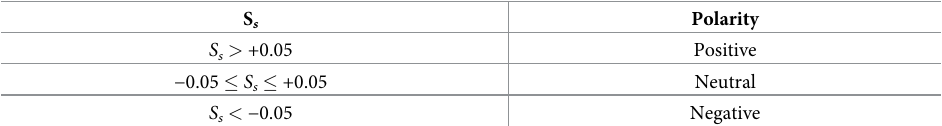
Table 1. Compound sentiment score and